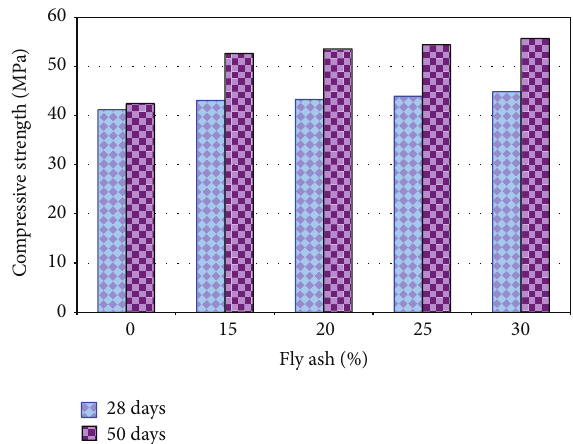
Figure 8: Transverse strength test